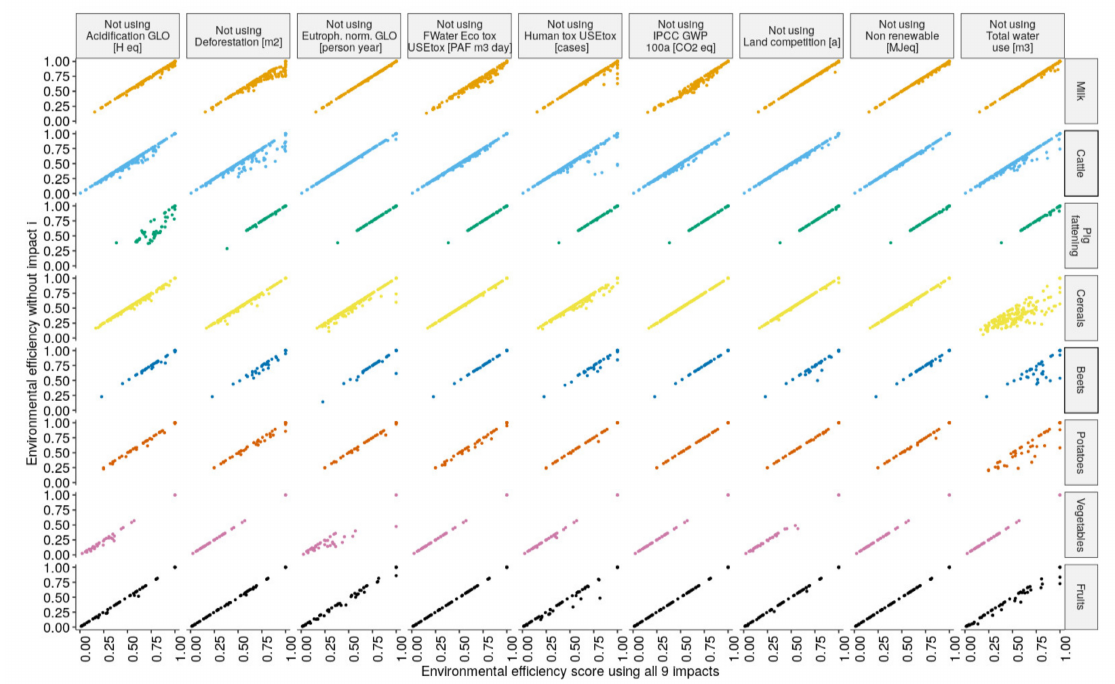
Figure A7. For each subplot, the impact described in the column title was omitted. The values on the x -axis are the original environmental efficiency scores, the value on the y -axis are the scores without the impact.